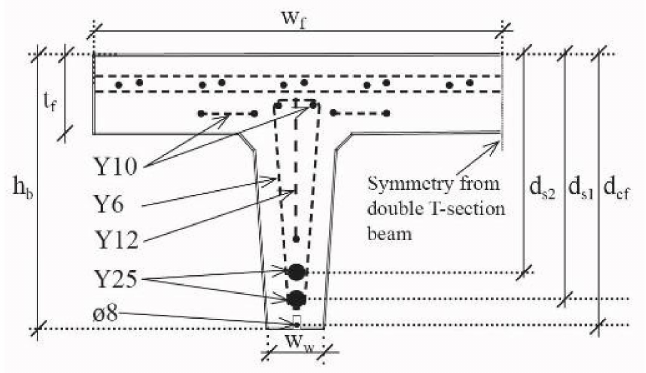
Figure 2. Cross section measures and reinforcement location. The longitudinal tensile reinforcement consisted of 2Ø25 deformed steel reinforcement bars, and the top reinforcement consisted of longitudinal Ø10 bars as well as two rein- forcement grids. The Ø6 stirrups were spaced by 100 mm and with a double spacing after 1.4 m from the extremities until the beam middle (see Figure 1). More detailed